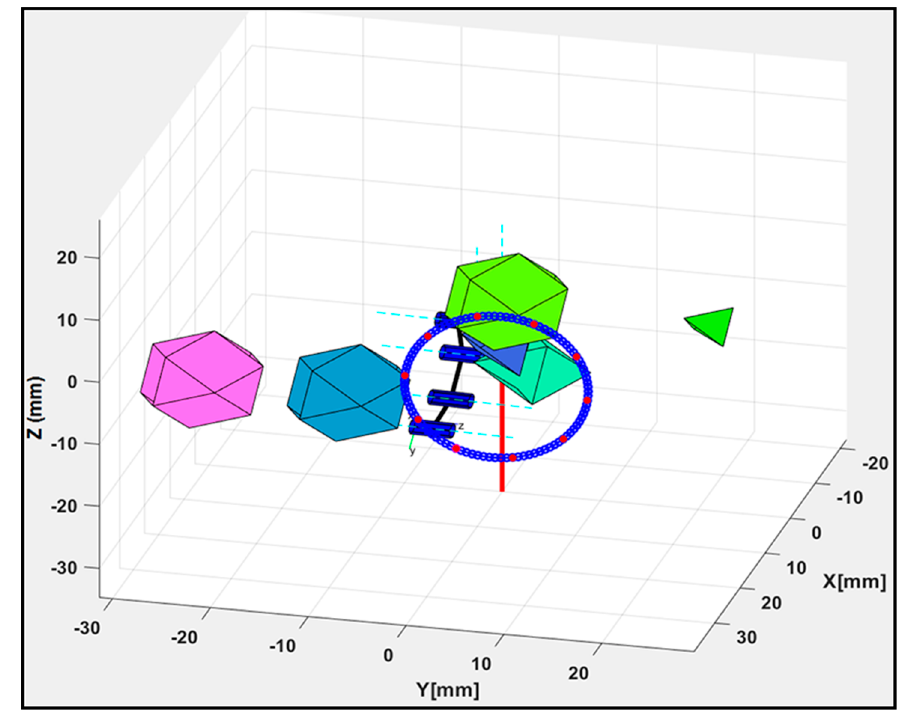
Figure 10. Obstacle avoidance of the robot for the trajectory case with n = 10.